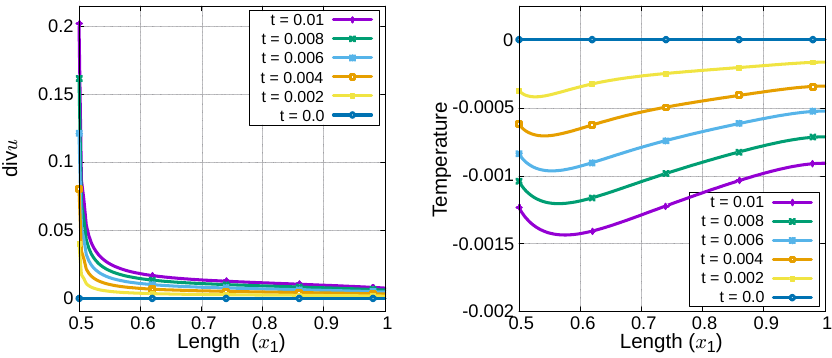
Figure 6. Profile of div u ( left ) and temperature Θ ( right ) using δ = 0.1 along the x 1 axis, i.e., x 2 = 0, 0.5 ≤ x 1 ≤ 1, during the loading process.